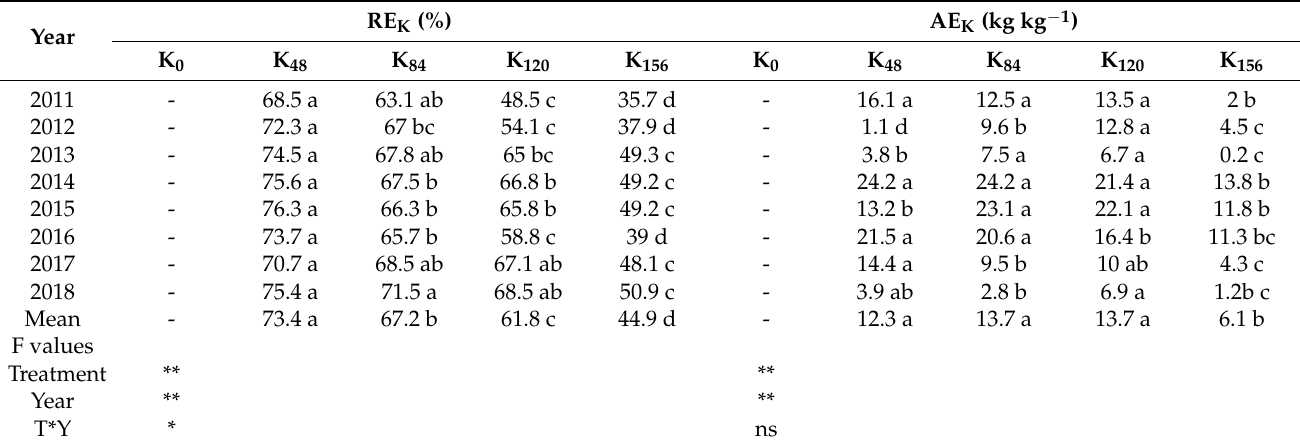
Table 2. Effects of different K fertilization rates on K recovery efficiency (RE K ) and K agronomic efficiency (AE K ) in wheat season between 2011 and 2018.